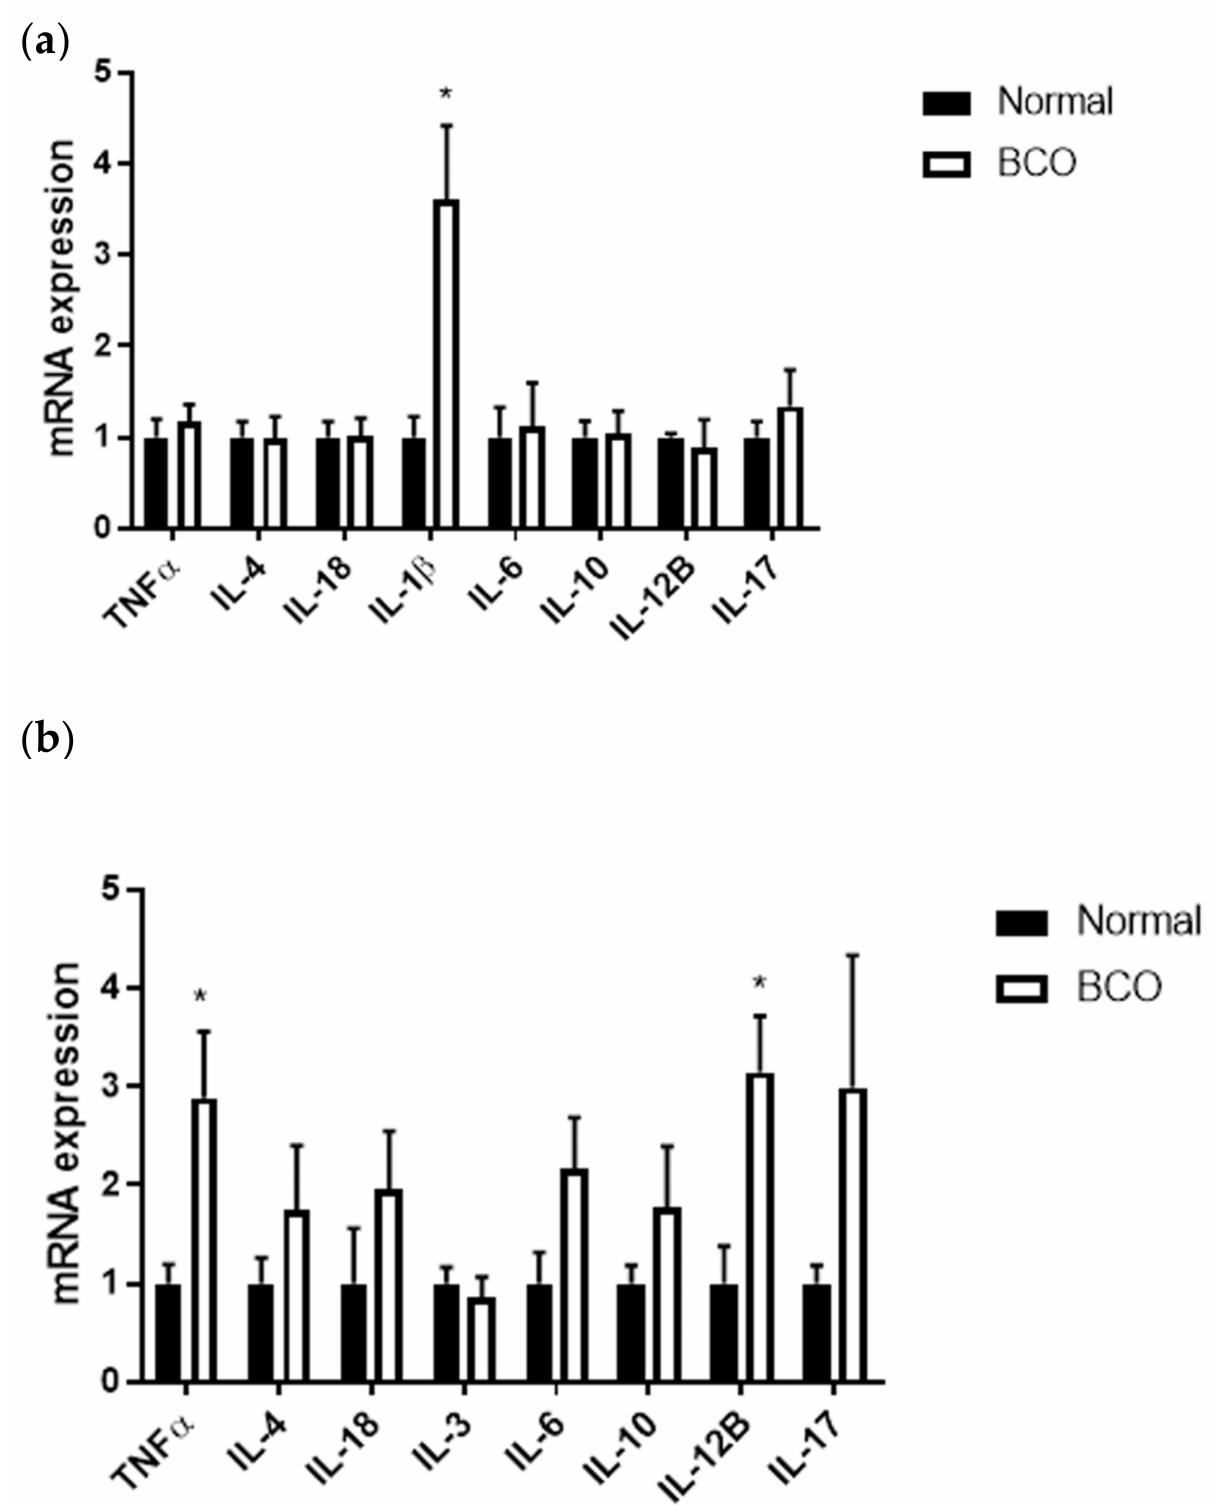
Figure 2. Local and systemic cytokine profile in normal and BCO-affected broilers. Gene expression for TNF α , IL-4 , IL-18 , IL-1 β , IL-6 , IL-10 , IL-12B , IL-17, and IL-3 in bone ( a ) and blood ( b ) of normal and BCO-affected broiler chickens. Significance was determined using a student t -test with p -value < 0.05. * indicates significant difference between normal and